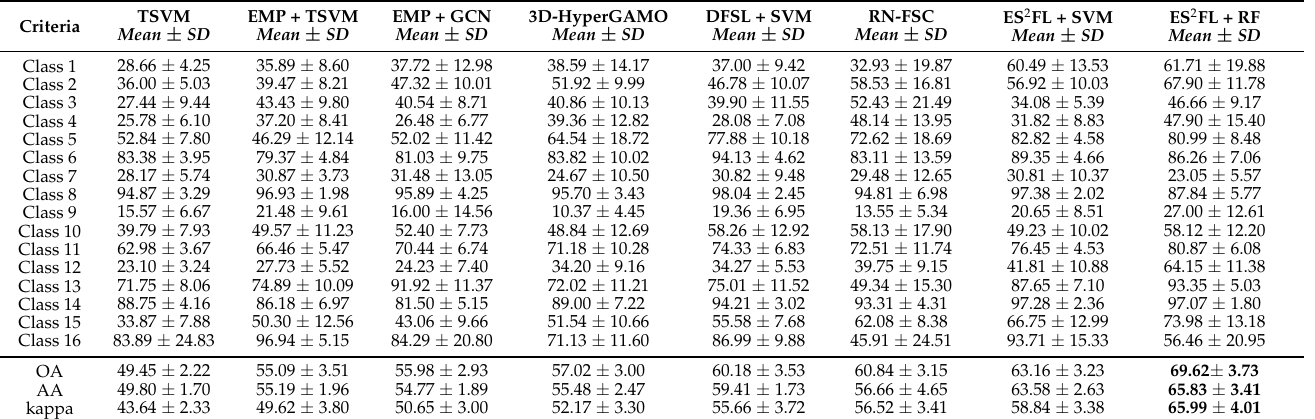
Table 5. The classification results of different methods on the IP data set in the case of small samples. SD denotes the standard deviation of 10 experimental results.